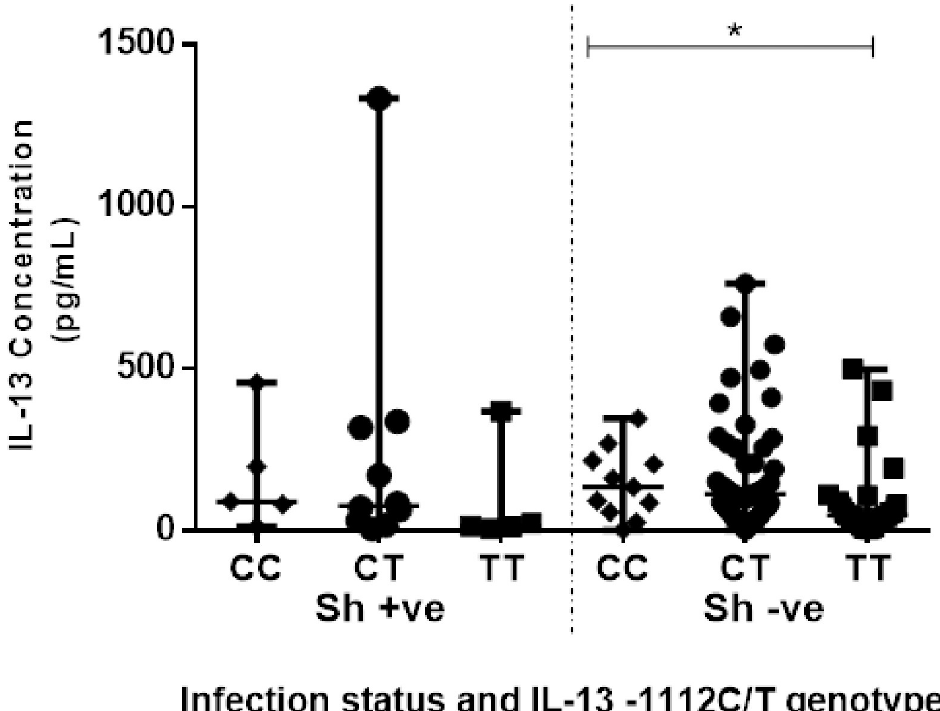
Fig 4. Comparison of the IL-13 cytokine level in IL-13 -1112C/T variants.